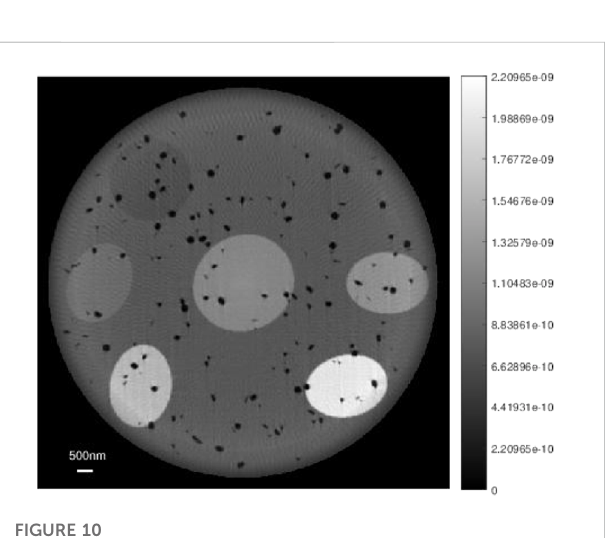
FIGURE 10 The inversion result using PRM for noisy data with noise-level